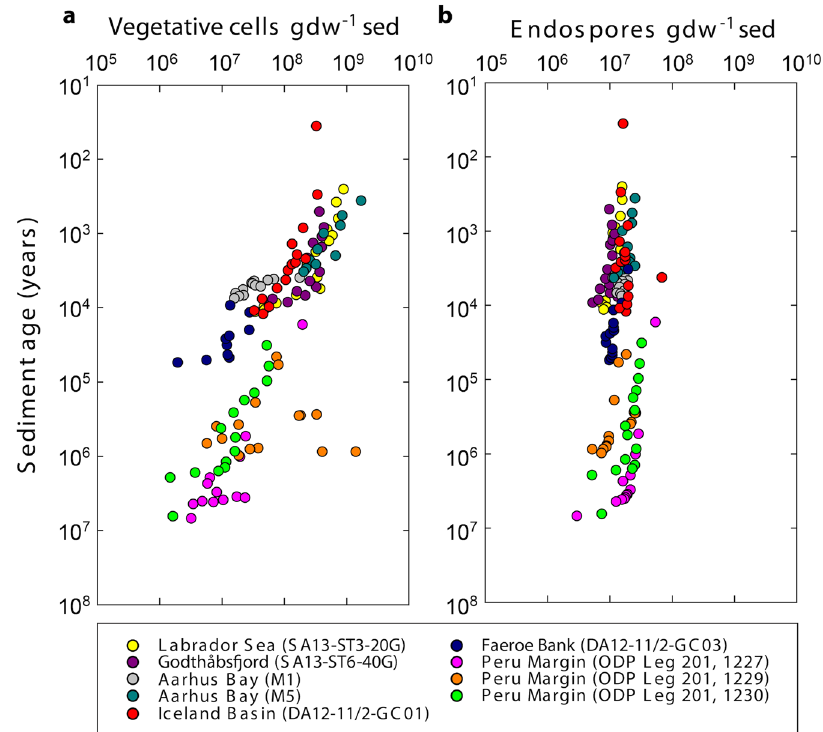
Figure 1. Abundance of vegetative cells ( a ) and bacterial endospores ( b ) versus sediment age. Vegetative cell abundance was determined from epifluorescence microscopy. Endospores were quantified from the bacterial endospore marker dipicolinic acid (DPA). Vegetative cell counts for samples from the Labrador Sea and the Godthåbsfjord were first published in ref. 73. Vegetative cell counts for samples from Aarhus Bay and the Peru Margin are taken from refs 6 and 33, respectively. Endospore data for the Peru Margin and Aarhus Bay are taken from refs 5 and 6, respectively. The unit ‘per gram dry weight sediment’ is abbreviated with ‘gdw − 1 sed’. Note the logarithmic scales on all